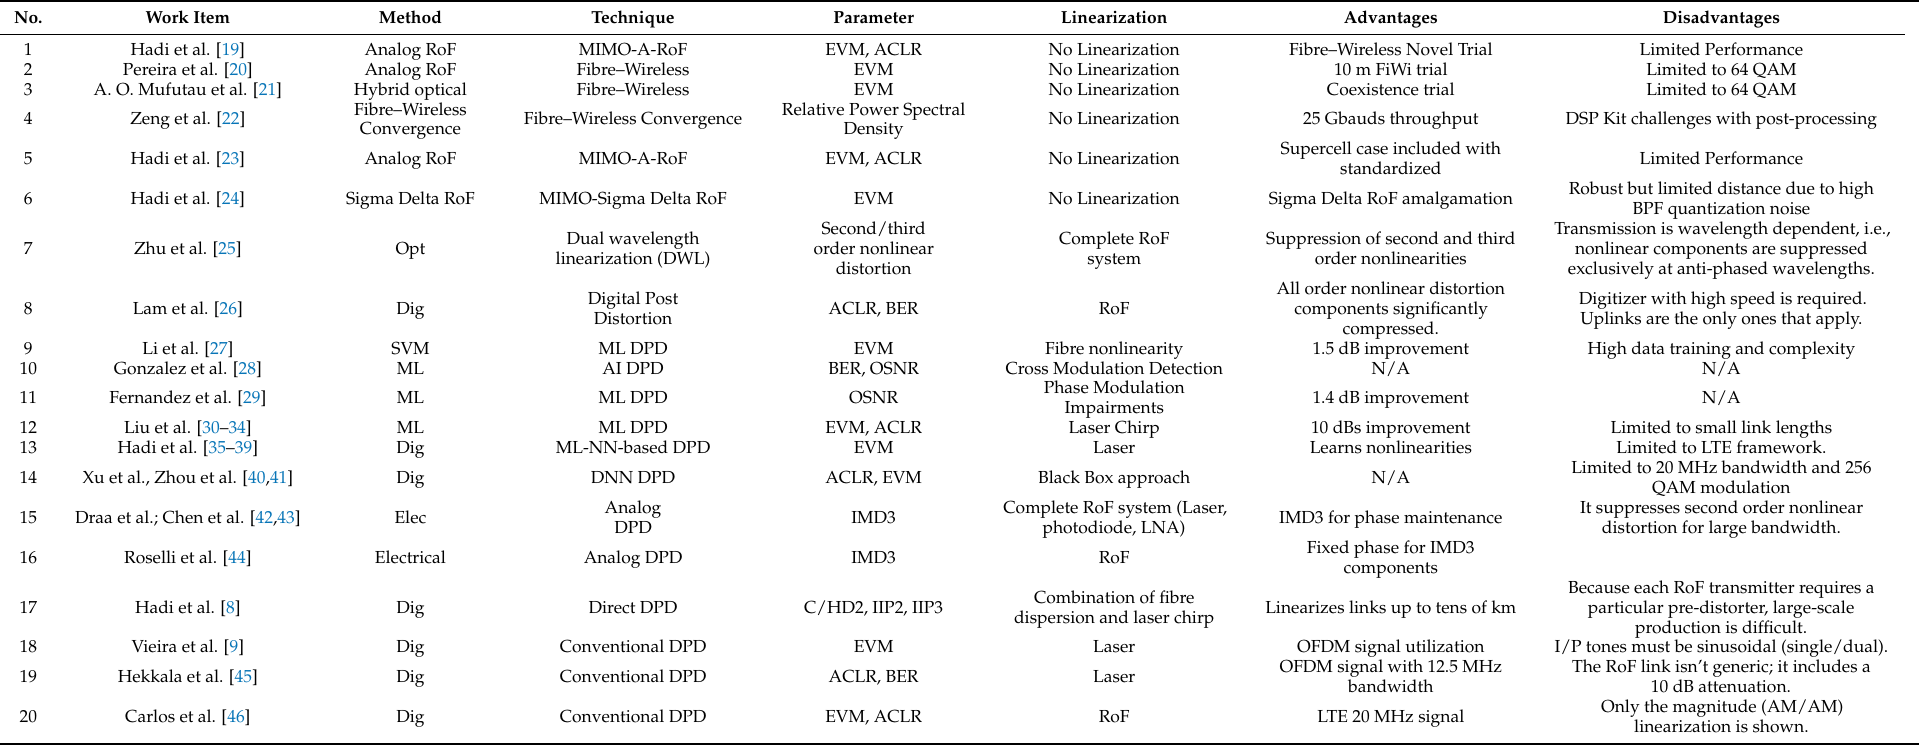
Table 1. State of the art for fibre–wireless RoF-based system and nonlinearity mitigation methods employed. The table abbreviates the nonlinearity